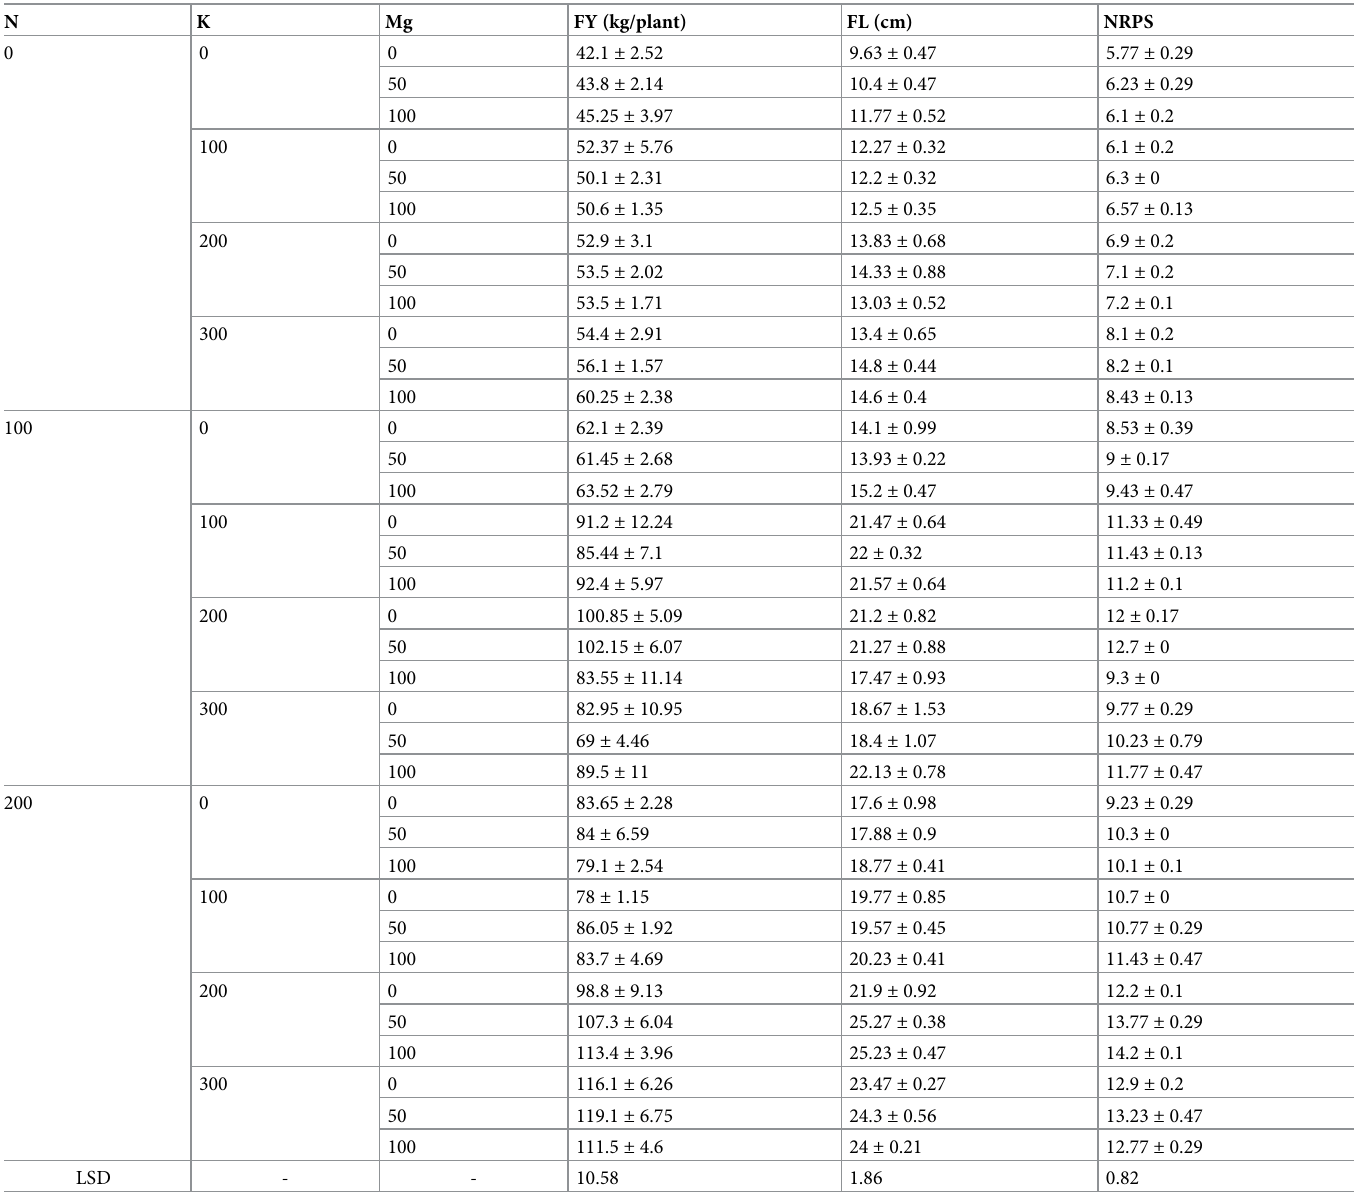
Table 1. The effects of N, K, and Mg on FY, FL, and NRPS in banana. N